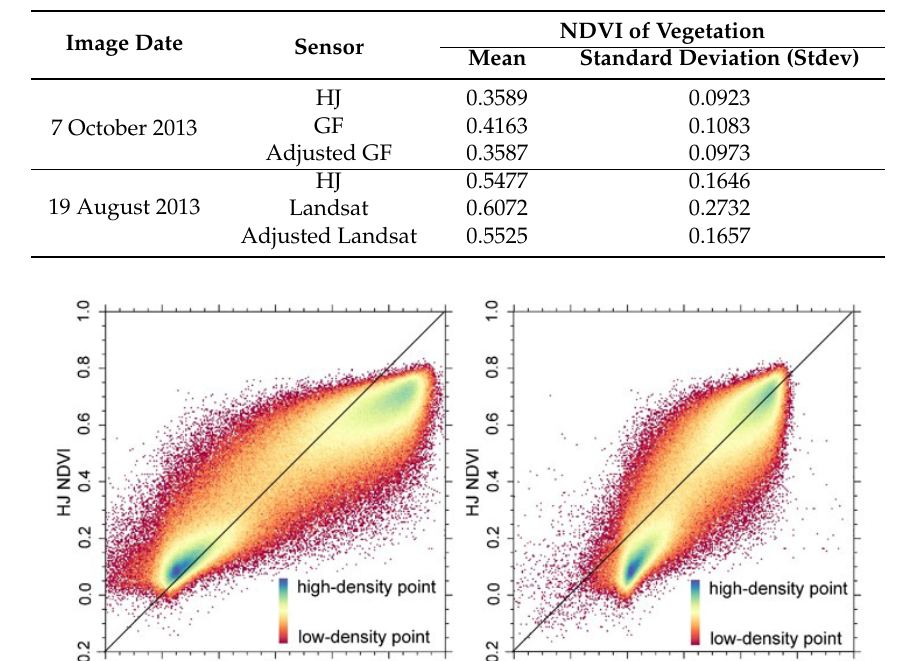
Table 4. Normalized Different Vegetation Index (NDVI) statistics of vegetation of each sensors in Luntai.